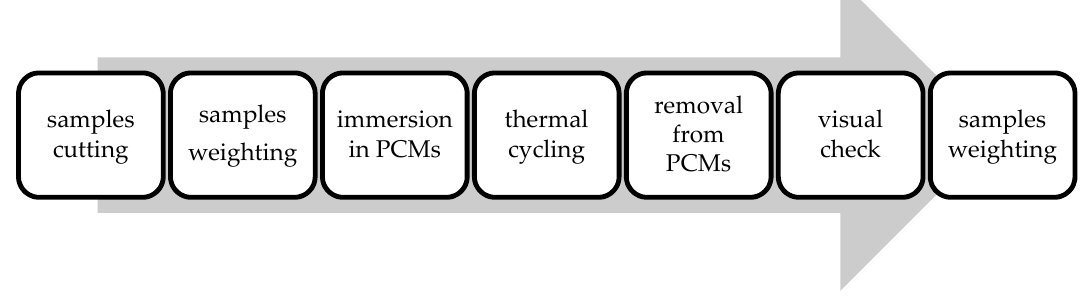
Figure 7. Individual steps of the experimental procedure.